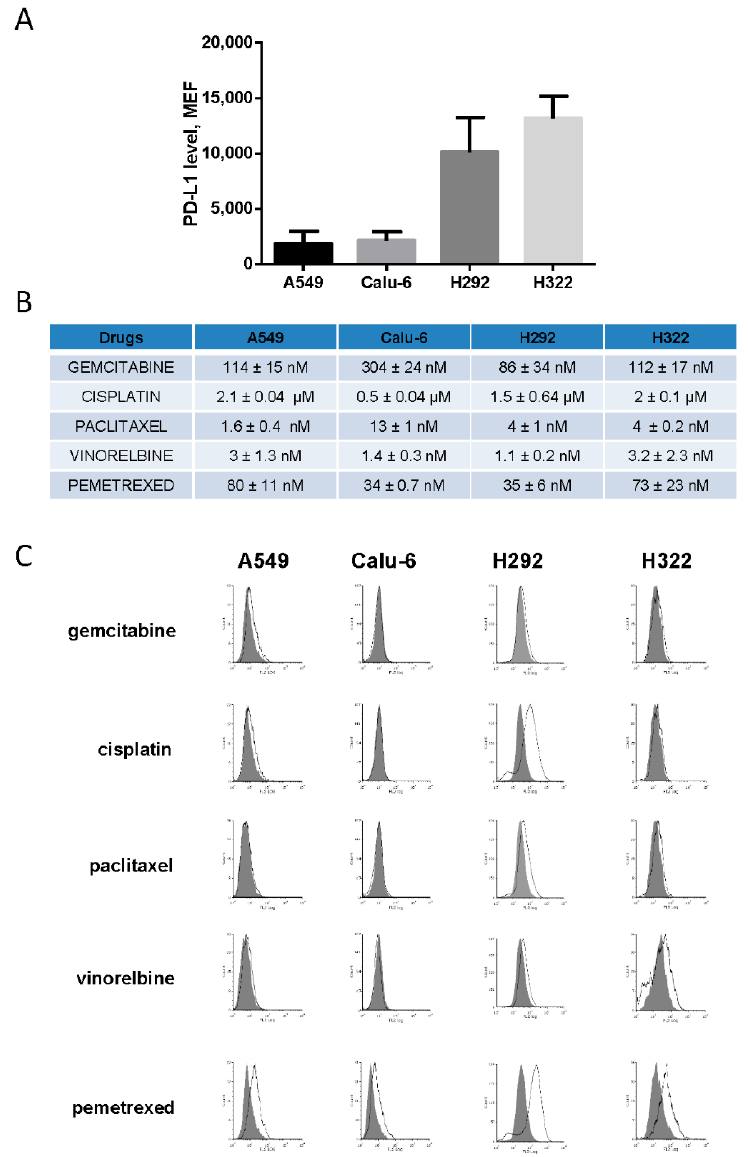
Figure 1. Modulation of programmed cell death ligand-1 (PD-L1) levels by chemotherapeutic drugs in non-small-cell lung cancer (NSCLC) cell lines. ( A ) A549, Calu-6, H292, and H322 cells were cultured in complete medium and after 24 h, the cells were collected and PD-L1 expression was evaluated by flow cytometry and quantified as molecules of equivalent fluorochrome (MEF). ( B ) Cancer cells were treated with increasing concentrations of the indicated drugs for 72 h. IC 50 values ± SD were calculated using GraphPad Prism 6.00 software. ( C ) NSCLC cells were treated with gemcitabine, cisplatin, paclitaxel, vinorelbine, or pemetrexed at IC 50 concentrations. After 3 days, PD-L1 levels were analyzed by flow cytometry. ( D ) Confocal immunofluorescence analysis of PD-L1 expression in H322 cells maintained in the absence or in the presence of 100 nM pemetrexed for 72 h; green fluorescence indicates the positivity to PD-L1. The nuclei were stained with Draq5 (red fluorescence). Scale Bar: 10